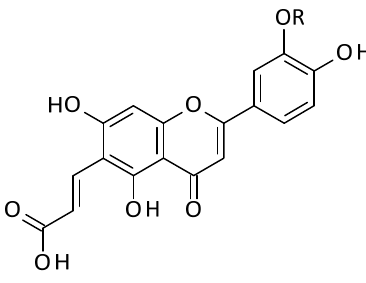
Figure 4. Flavonoids from Alternanthera philoxeroides . Flavonoids of this plant mainly possess chrysoeriol ( 19 ) and luteolin ( 22 ) skeletons, and alternanthins appear to be the signature flavonoids of this species [4–6,10,11]. One of the unique features of some flavonoids of this plant is the presence of the deoxysugar boivinopyranose, which forms the C-glycosidic link to the flavonoid aglycone, as found in alternanthin ( 13 ), alternanthin B ( 14 ), and a few other chrysoeriol/luteolin glycosides ( 15 – 18 ). While three propenoic acid substituted flavonoids, demethyltorosaflavone D ( 26 ), lu- teolin 8-C- E -propenoic acid ( 25 ), and torosaflavone ( 27 ), appear to be among the less com- mon natural flavonoids, kaempferol ( 21 ), luteolin ( 22 ), quercetin ( 23 ), and rutin ( 24 ) are among the most abundant natural flavonoids . Alternanthin ( 13 ), the signature flavonoid of this plant, was first isolated as a novel flavonoid C-glycoside containing the rare deox- ysugar boivinose from an ethanol (EtOH) (95%) extract of the stems and leaves of this plant using repeated column chromatography on silica gel and the structure was deduced with the help of UV–Vis and nuclear magnetic resonance (NMR) experiments, particularly a series of 1D nOe spectral analyses [4]. Khamphukdee et al. [11] used solvent partitioning (with chloroform and EtOAc) of an EtOH extract of the aerial parts of this plant, followed by column chromatography on silica gel to isolate demethyltorosaflavone B ( 20 ) and to- rosaflavone ( 27 ) together with five other previously reported flavonoids. Among the 15 isolated flavonoids from A. philoxeroides , 11 are flavone (no substitution at C-3) and the remaining four are flavonol derivatives (oxygenation at C-3). Flavonoids possess various pharmacological properties including anti-ageing, anti- cancer, anti-inflammatory, antioxidant, antimicrobial, antiparasitic, antiviral, cancer chemopreventive, cardioprotective, hepatoprotective, and immunomodulatory proper- ties [23]. Several flavonoids (e.g., quercetin ( 23 ) and rutin ( 24 )), are used in various tradi- tional medicinal formulations and in some ‘over the counter’ medications [23,30–32]). In